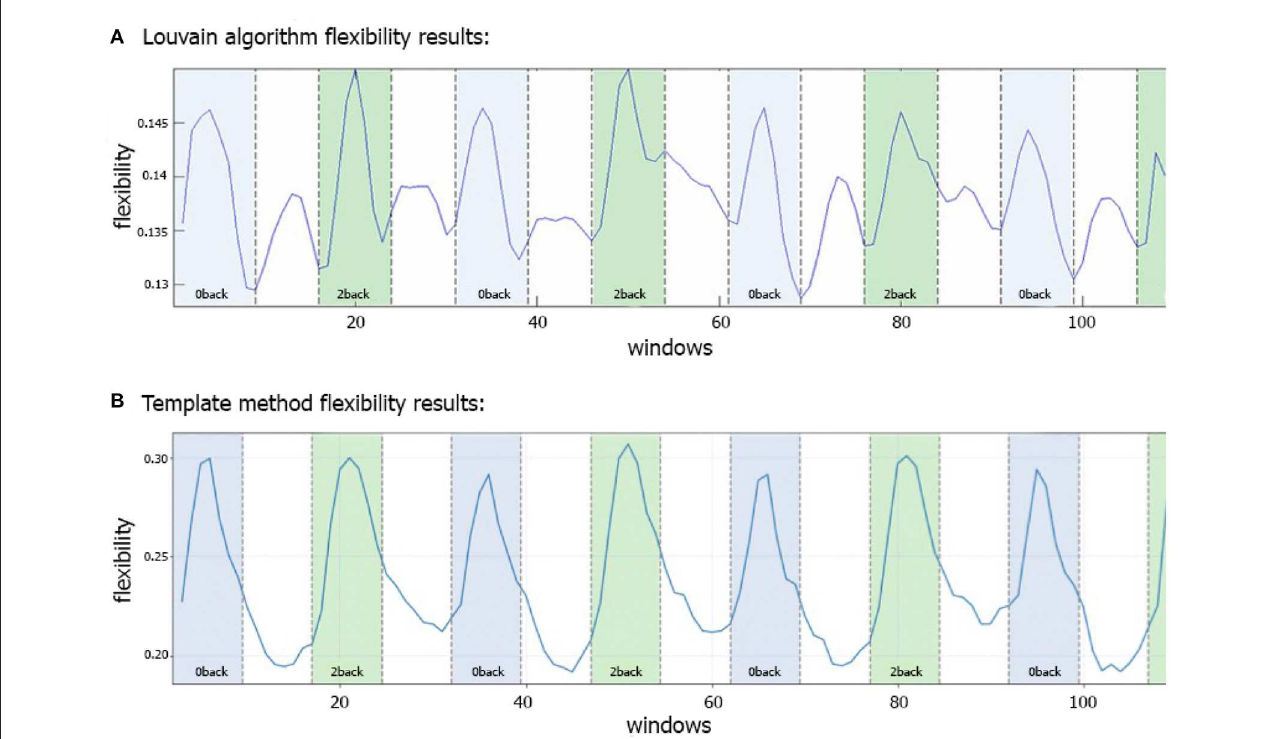
FIGURE3 Comparison of flexibility generated by the generalized Louvain-like locally greedy heuristic algorithm (Blondel et al., 2008; Jeub et al., 2022) and the template-based method during an N-back working memory task. (A) Flexibility plot from Braun et al. (2015) illustrating the probability that a brain region changes its modular allegiance between two consecutive windows in a sample of 344 healthy subjects. The original plot is used with permission of the publisher. (B) Flexibility plot generated by the template-based method. Here, the flexibility number in each time-window is the fraction of regions that change their affiliation from one time window to the next (i.e., the number of changed regions divided by the total number of nodes). The plots are generated using a subset of 331 subjects from the same cohort as used in Braun et al. (2015). Note that in both plots a time window covers 15 EPI volumes with a TR of 2s, corresponding to a window length of 30s. The window was shifted with one volume at a time, allowing for 14 EPI volumes overlap between consecutive windows, which yielded 114 windows in total.